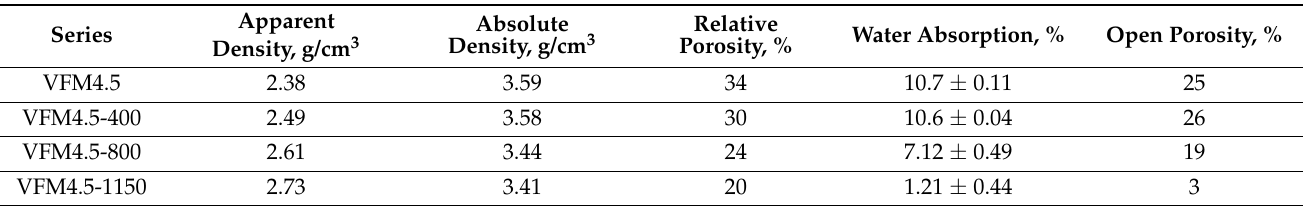
Table 2. Physical properties of the initial and thermally treated geopolymers series to 400, 800 and 1150 °C.